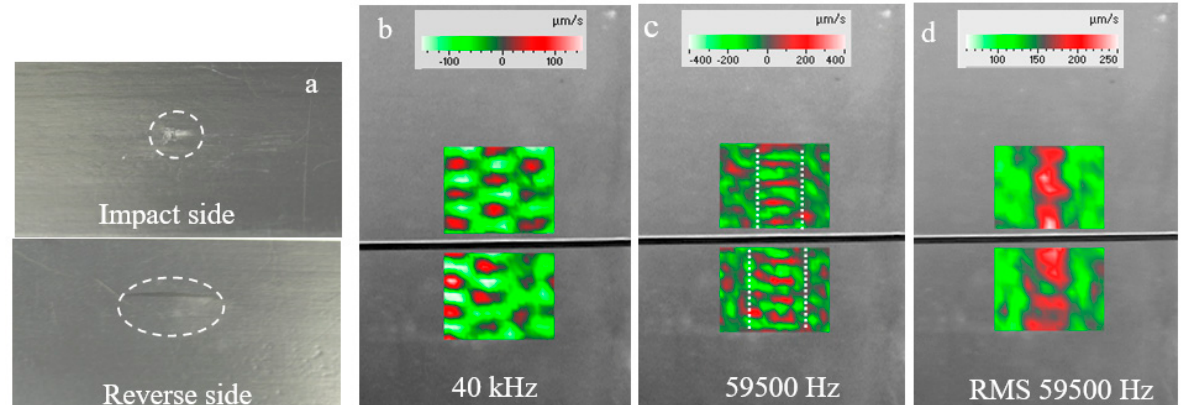
Figure 5. Airborne AE from impact damage in CFRP plate ( a ): standing wave pattern at 40 kHz ( b ); RACE at LDR frequency ( c , d ).